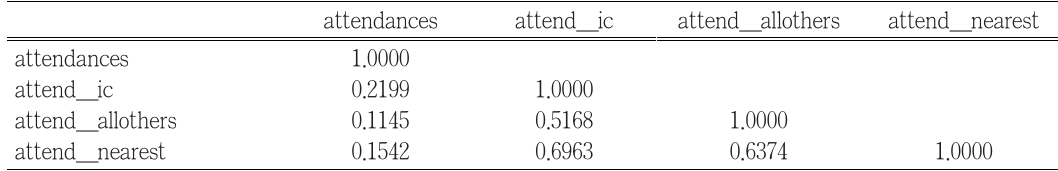
<Table 3> Correlation Table (Instrumental